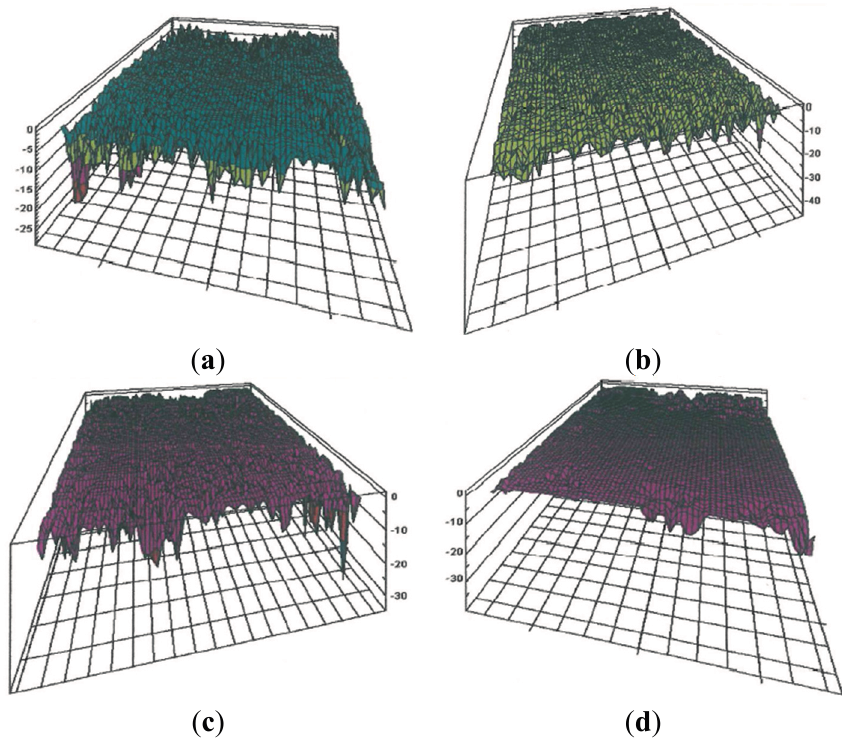
Figure 2. Diagrams of facial wrinkles before ( a ) and after ( b ) treatment with emulsion A1 and before ( c ) and after ( d ) treatment with emulsion